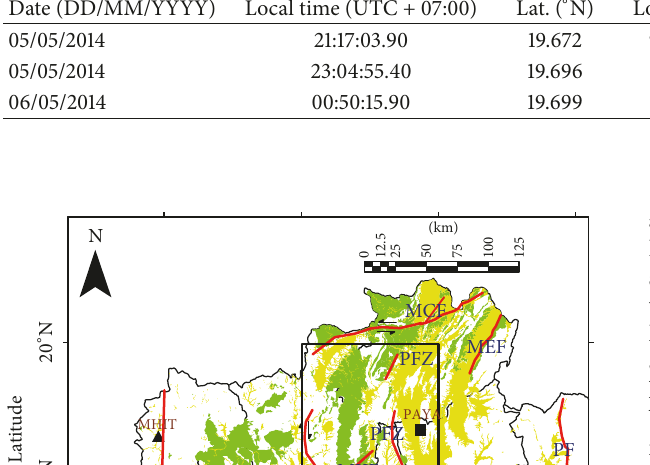
northern part lies in the NE-SW direction with left-lateral strike-slip. The southern part of the fault lies in the N-S direction with right-lateral